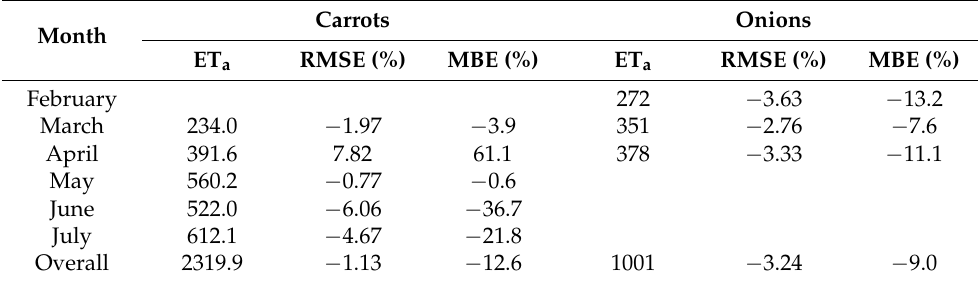
Table 5. Crop water use (ET a , mm) values were estimated based on remote sensing models. MBE = mean bias error (%); RMSE = Root mean square error (%).